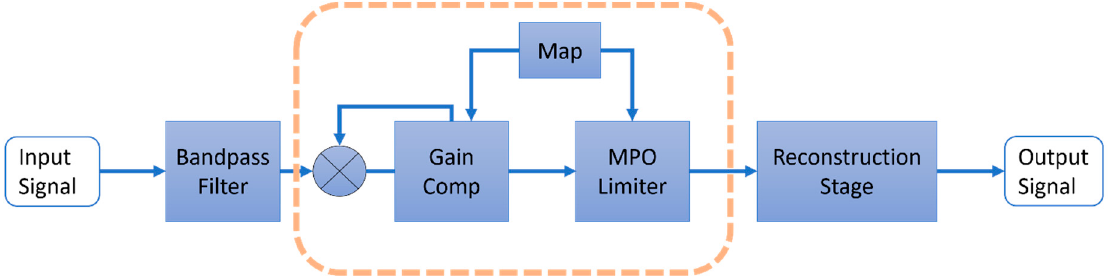
Figure 2. ADRO modules.